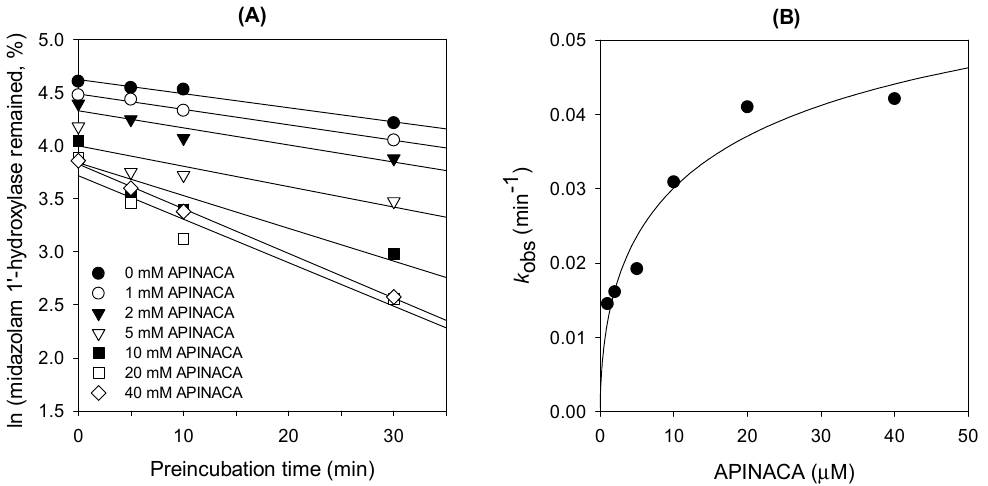
Figure 2. Inhibitory effect of APINACA on CYP1A2-mediated phenacetin O -deethylase, CYP2A6- mediated coumarin 7-hydroxylase, CYP2B6-mediated bupropion hydroxylase, CYP2C8-catalyzed amodiaquine N -deethylase, CYP2C9-catalyzed diclofenac 4 ′ -hydroxylase, CYP2C19-mediated [ S ]- mephenytoin 4 ′ -hydroxylase, CYP2D6-mediated bufuralol 1 ′ -hydroxylase, and CYP3A4-mediated midazolam 1 ′ -hydroxylase activities in ultrapooled human liver microsomes with ( ) and without ( ) a 30-min preincubation in the presence of NADPH at 37 ° C. The cocktail substrate concentrations used to assess the IC 50 values were as follows: 50 μ M phenacetin, 2.5 μ M coumarin, 2.0 μ M amodiaquine, 10 μ M diclofenac, 100 μ M [ S ]-mephenytoin, 5.0 μ M bufuralol, and 2.5 μ M midazolam. Inhibition of CYP2B6 was evaluated separately using 50 μ M bupropion. The data are the means ± SD ( n = 3). The data represent the average of three measurements. The K i and k inact values of APINACA for the time-dependent inhibition of CYP3A4-catalyzed (cid:48) − 1 midazolam 1 -hydroxylase were 4.5 µ M and 0.04686 min , respectively (Figure 3).